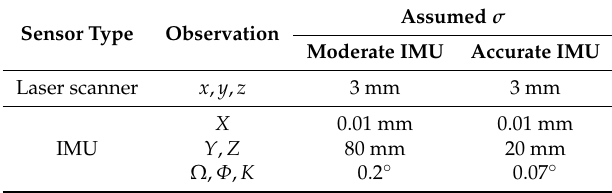
Table 1. Scheduled standard deviations σ for the variance-covariance matrix (VCM) Σ vv of the observation vector l k .